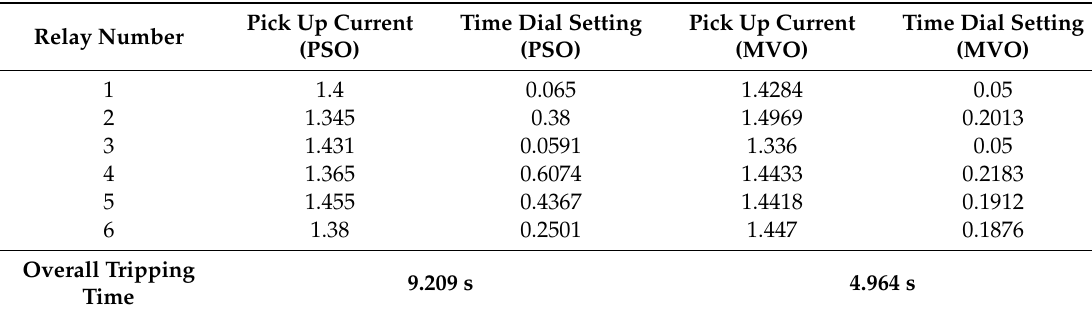
Table 2. Simulation results for IEEE 3 bus system where the overall operating time (OT) is optimized using particle swarm optimization (PSO) and MVO algorithms.